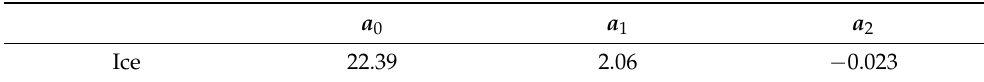
Table 5. The value of the constant.